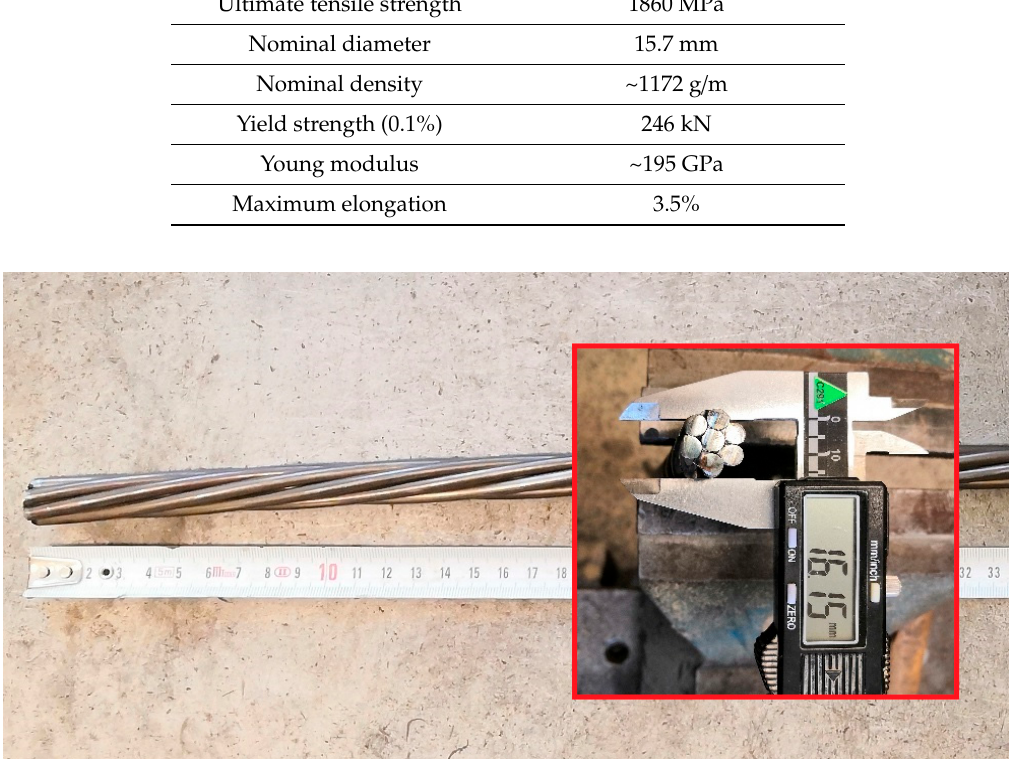
Figure 3. Visual characterization of non-prestressed tendon used for the measurement of the bond strength in UHPC.